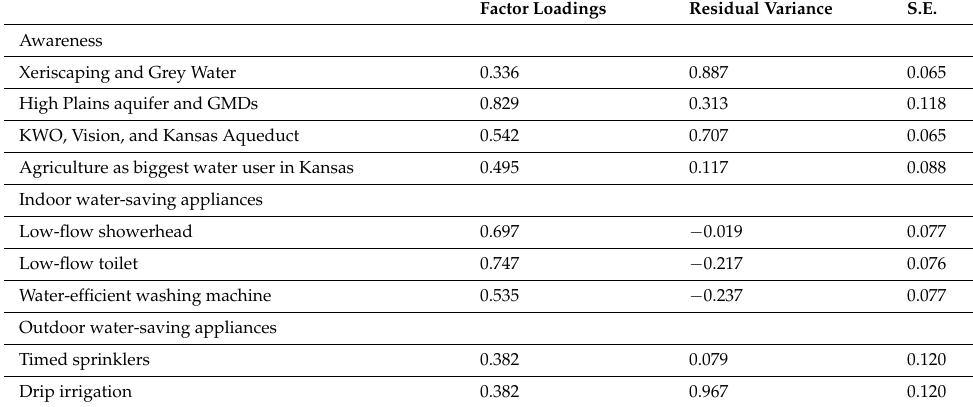
Table A5. Standardized model results of owning water-saving appliances for appliances for indoor and outdoor usage regressed on awareness levels for well owners with municipal utility connections (n =